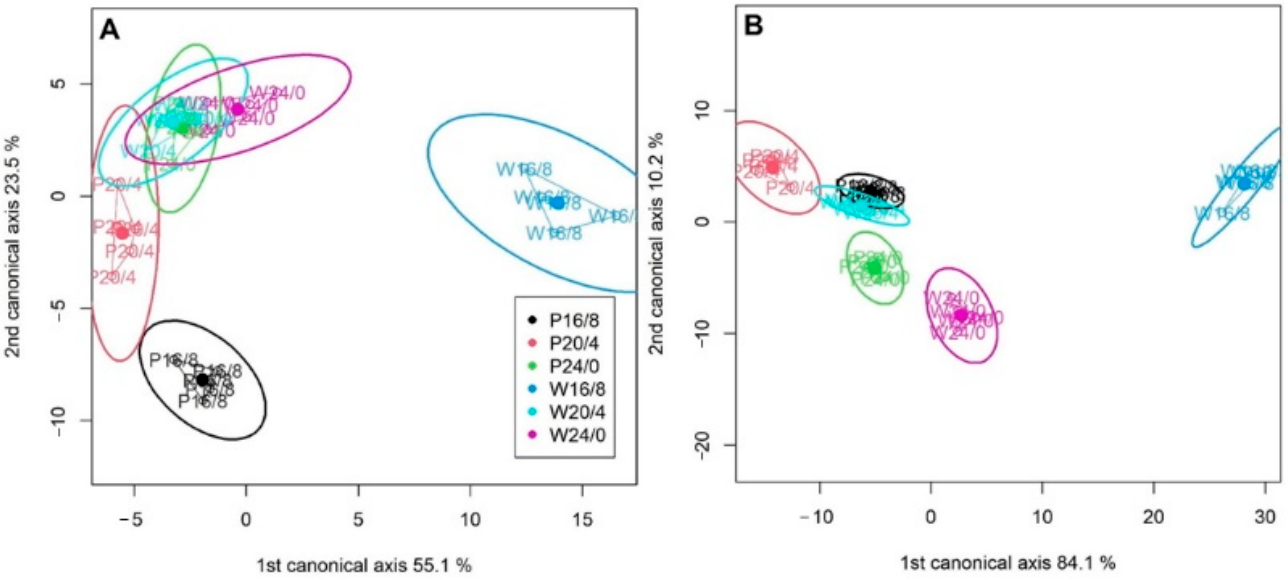
Figure 3. Cannonical variate analysis (CVA) representing the explanatory variables within Cannabis cultivars Finola ( A ) and USO31 ( B ) exposed to 16/8, 20/4, and 24/0 photoperiods and grown under white (W) and purple (P) light. Points represent values for each treatment. Ellipses around the different groups represent the 95% confidence intervals.